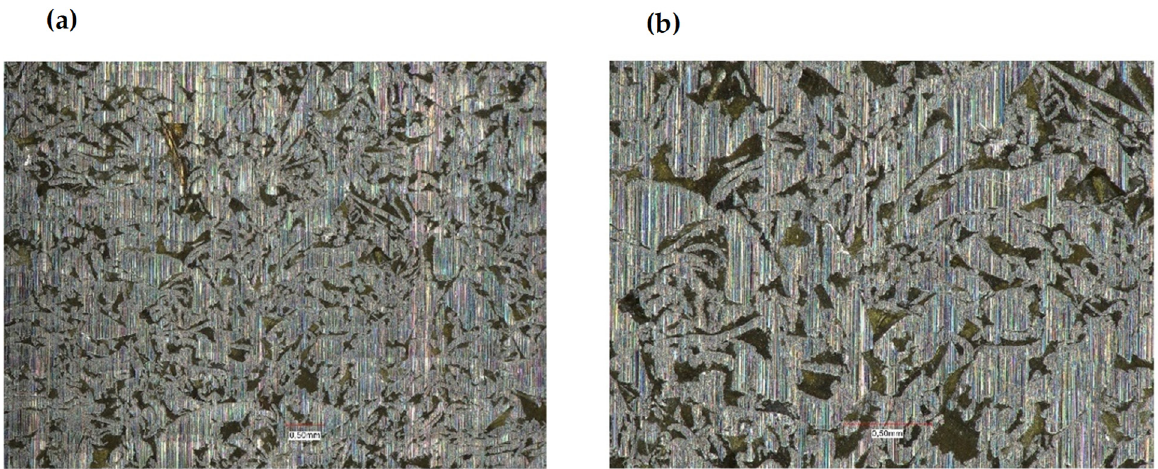
Figure 9. Composite of acrylic–phenolic resin with aluminum chips: ( a ) magnification 50×, ( b ) mag- nification 100×.